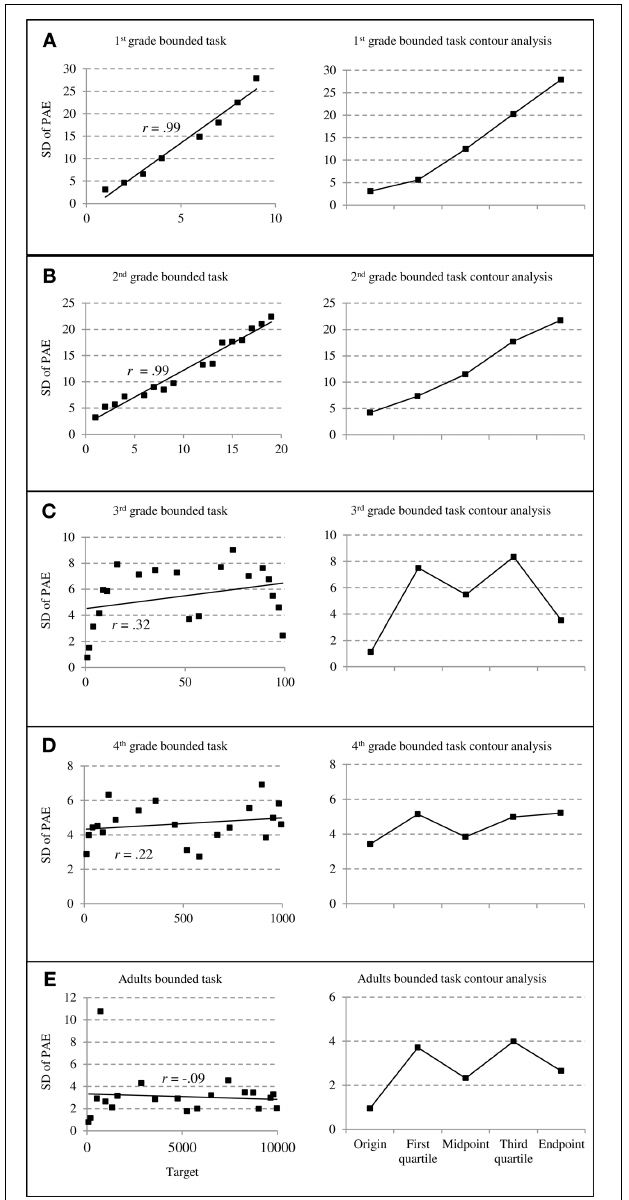
FIGURE 3 | Standard deviations of percent absolute errors (PAE) for bounded number line estimation performance. The left column depicts the relationship between standard deviations of PAEs and target numbers whereas the right column depicts results of counter analyses summarizing standard deviations of PAEs at specific reference points ( cf. Ashcraft and Moore, 2012; grade 1 through adults: A – E) .